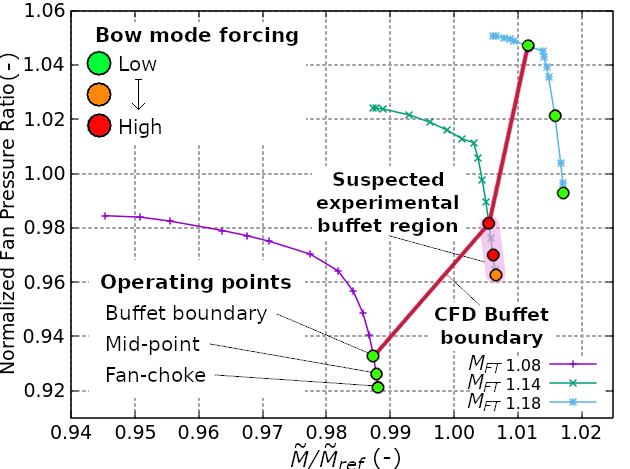
Figure 2. Engine operating map with marked OGV buffet boundary with normalised fan pressure ratio plotted against normalised mass flow rate calculated using non-dimensional mass flow rate ( ˜ M ) and a reference non-dimensional mass flow rate ( ˜ M ref